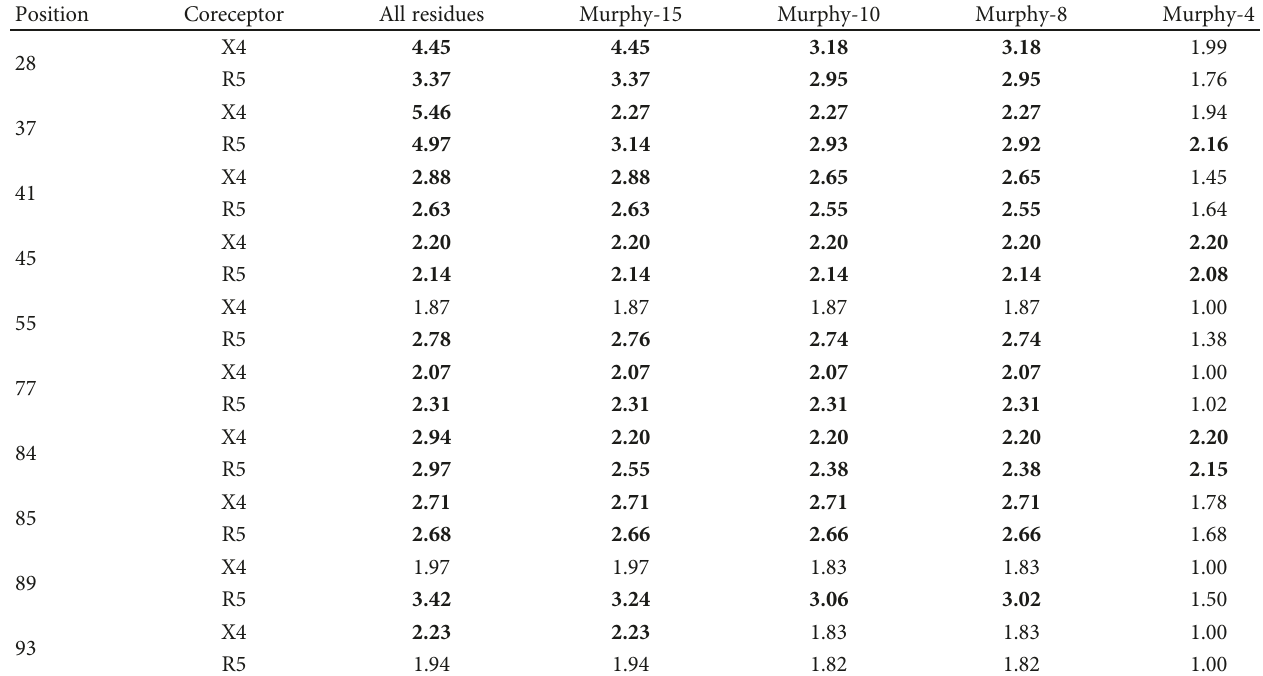
Table 2: Diversity values at amino acid positions in Vpr. Each position in the table had at least one diversity value greater than 2 in the full amino acid alphabet. A diversity value greater than 2 (bold) indicates a diverse amino acid